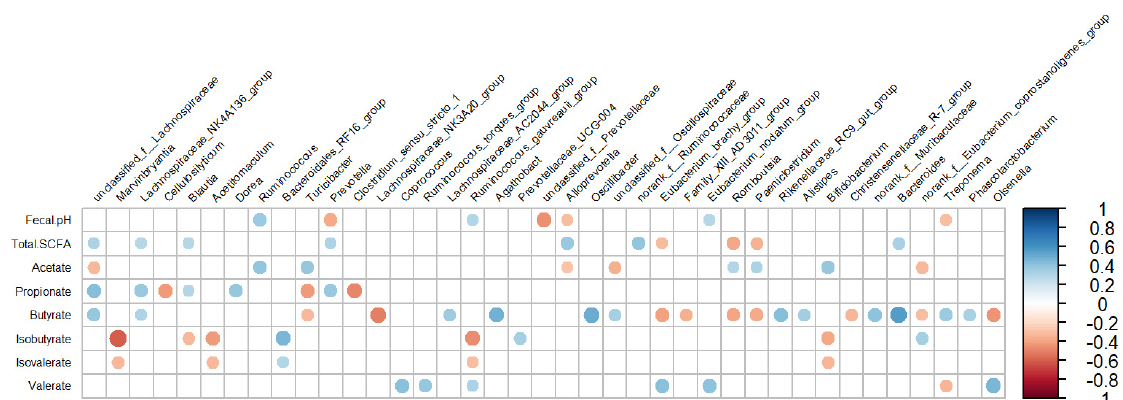
Figure 4. Correlation coefficients between the abundance of bacterial genera ( ≥ 0.1%) in feces and fecal pH and short-chain fatty acids for lactating cows fed treatment diets. Blue dots indicate a positive relationship between bacterial genus abundance and production parameters, while red dots represent a negative relationship between them. Larger dots indicate a stronger correlation.